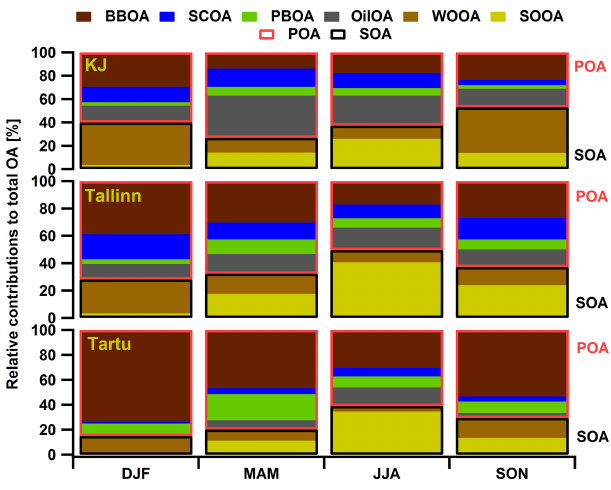
Figure 10. Seasonally averaged relative contributions of each fac- tor to the total OA per site. The red and black boxes indicate the contributions of primary and secondary OA,